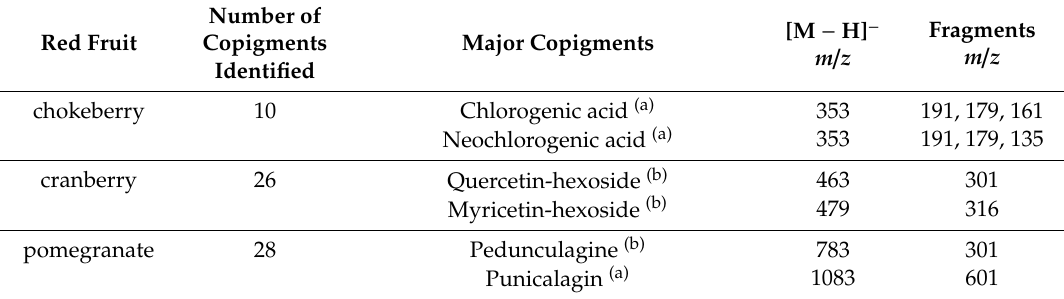
Table 2. Major copigments identified in the extracts of chokeberry, cranberry, pomegranate, blueberry, elderberry, red grape, sour cherry, and black currant identified in this study using (a) HPLC-ESI-MS n analysis and authentic references or (b) tentatively identified using HPLC-ESI-MS n analysis and literature data. For details, see the Materials and Methods section, Section